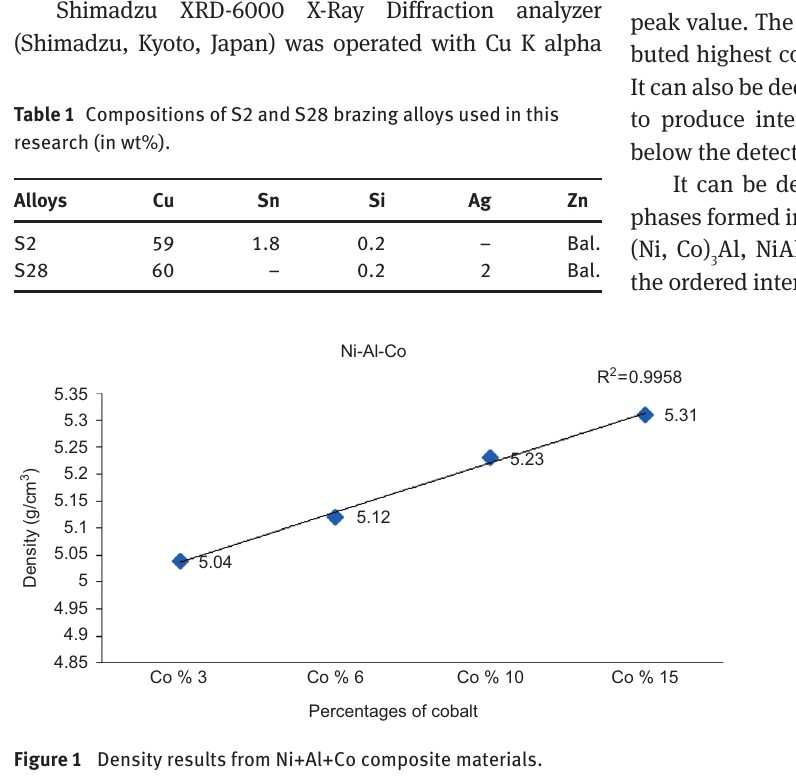
Figure 1 Density results from Ni+Al+Co composite